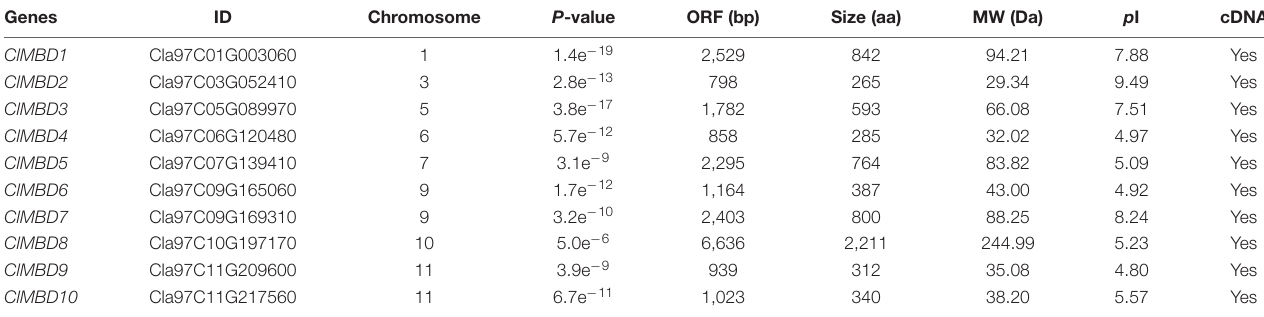
TABLE 1 | Information on the watermelon ClMBD family. Genes ID Chromosome P